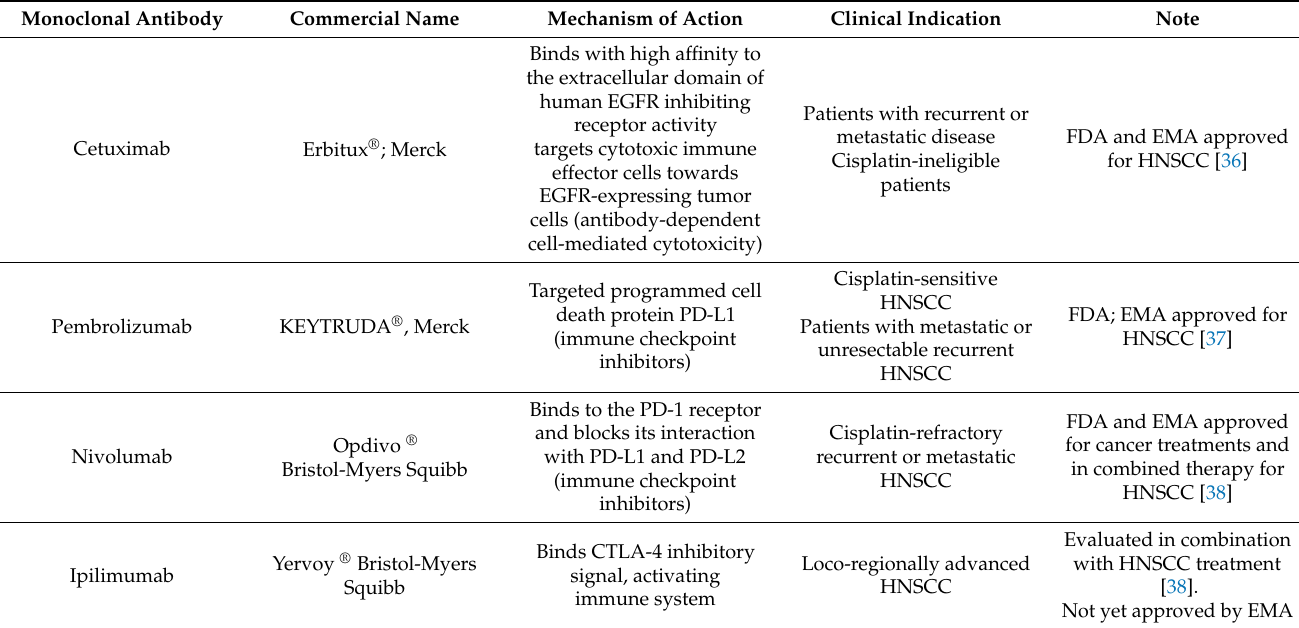
Table 2. Monoclonal antibodies currently used in HNSCCs